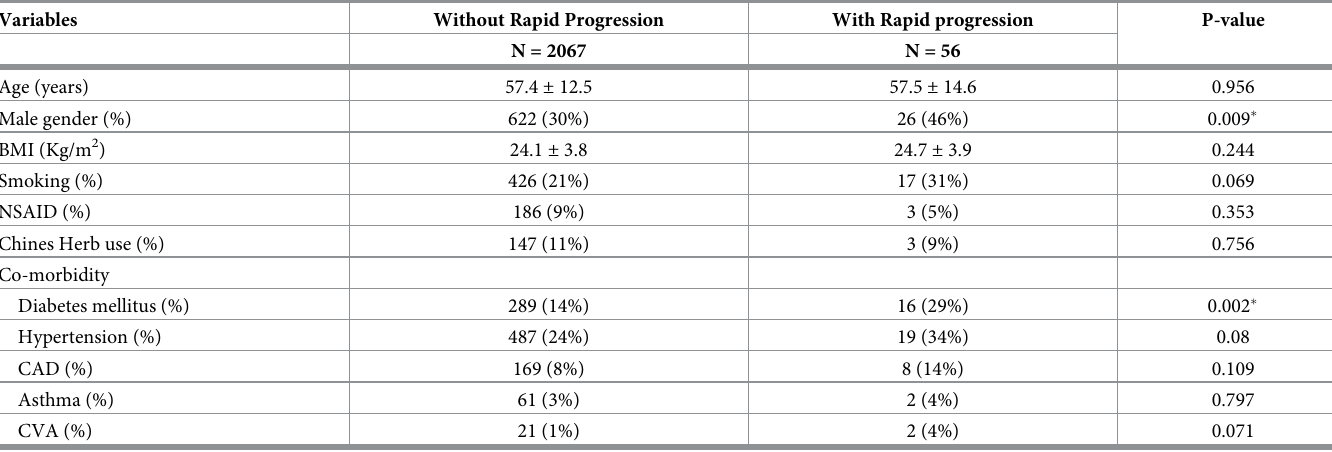
Table 4. Demographic data of study population with and without rapid progression of